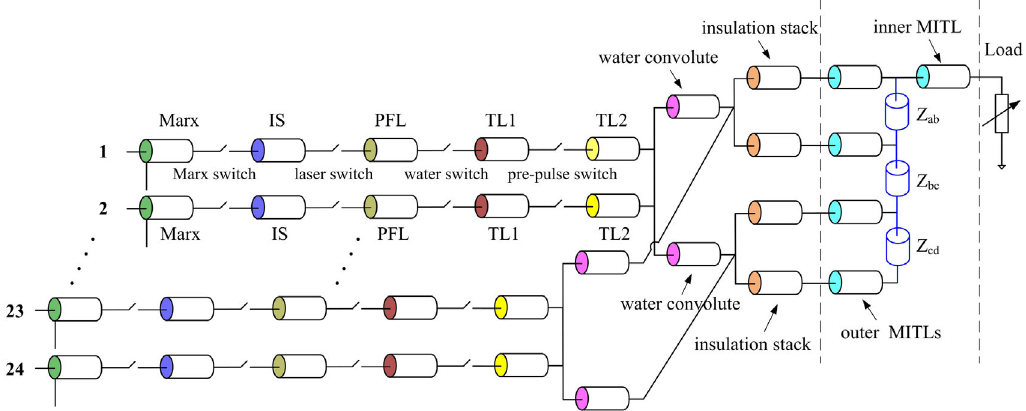
FIG. 3. Schematic model of the PTS with all twenty-four modules. All capacitors and inductors are transformed to TL elements. Each TL here actually represents a subcircuit consisting of capacitance, inductance or time-dependent resistance, or all of